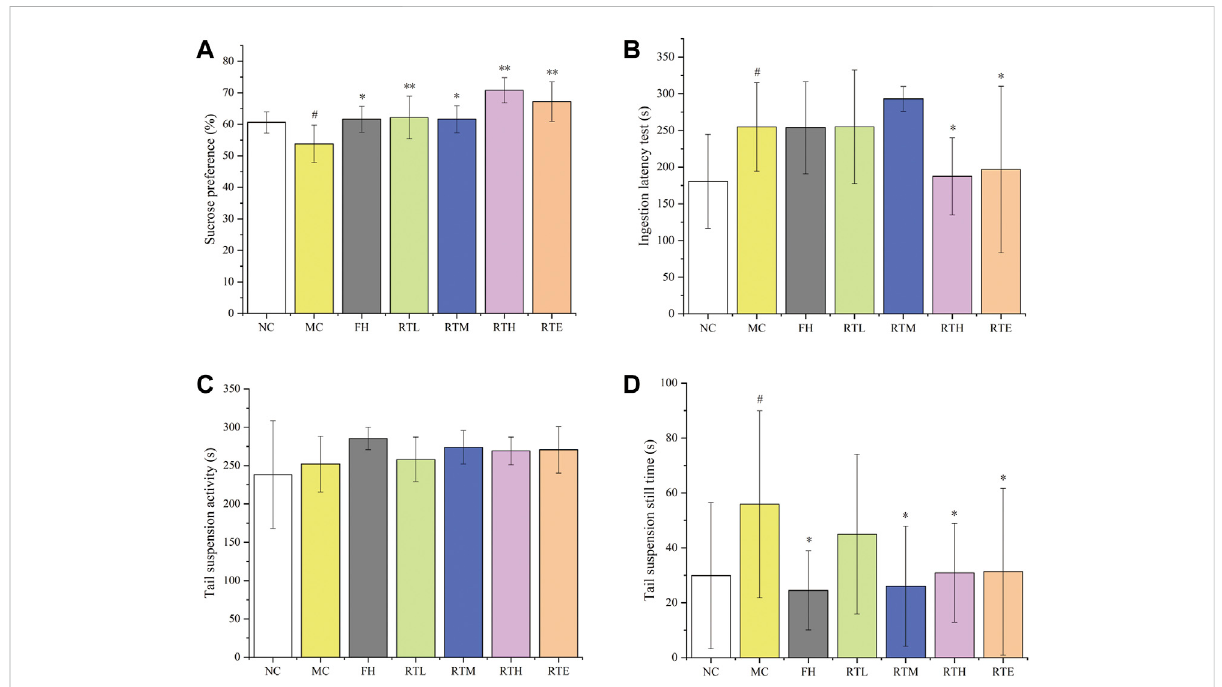
The effects of different dose groups of rutin on the behaviors of CUMS mice. (A) Sucrose preference test, (B) ingestion latency test, (C) tail suspension activity test, and (D) tail suspension still time test. Data are reported as mean ± SD. For statistical signi fi cant, # p < 0.05, ## p < 0.01 compared with the normal control group; * p < 0.05, ** p < 0.01 compared with the model control group. NC, normal group; MC, model group; FH, Fluoxetine hydrochloride group; RTL, low-dose of rutin (0.7 mg/kg); RTM, medium-dose of rutin (1.8 mg/kg); RTH: high-dose of rutin (6.3 mg/kg); RTE, extra high-dose of rutin (10.0